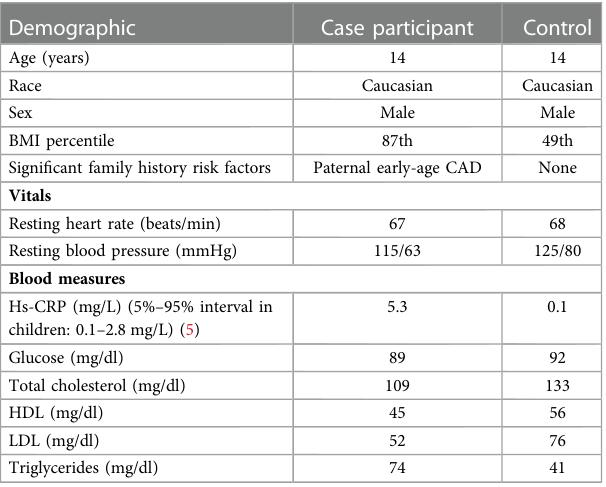
TABLE 1 Case participant and healthy control